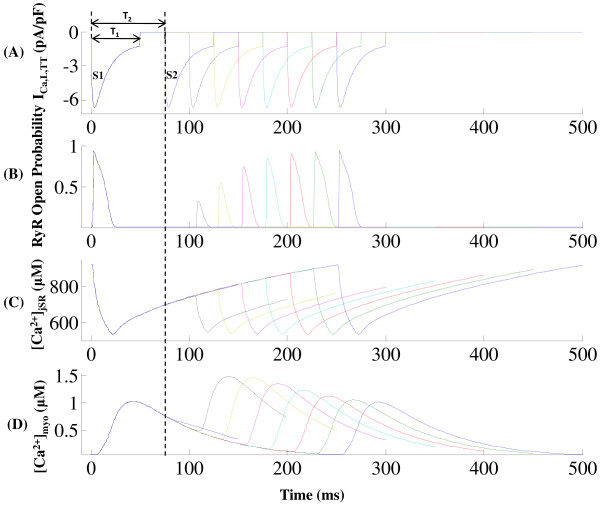
Figure 13: RyR refractory characteristics. (A) The stimulation protocol comprises of two consecutive stimuli S1 & S2, both of which are identical to the dyadic component (ICa,L,TT ) of trace 1 (ICa,L evoked by a 10 mv clamp pulse) in Figure 7A with a peak amplitude of 6.657 pA/pF and a duration (T1) of 50 ms. These are applied with their separation in time (T2) increasing from 50ms to 250 ms in steps of 25 ms. (B) The RyR sensitive Ca2+ release channel shows refractory characteristics with an absolute refractory period of 50 ms and a relative refractory period of 250 ms. (C) The corresponding [Ca2+]jSR traces reflect partial RyR recovery. (D) Cytosolic calcium transient recovers completely after 250 ms. The dotted line indicates lack of RyR release when T2 = 75 ms due to insufficient RyR recovery.